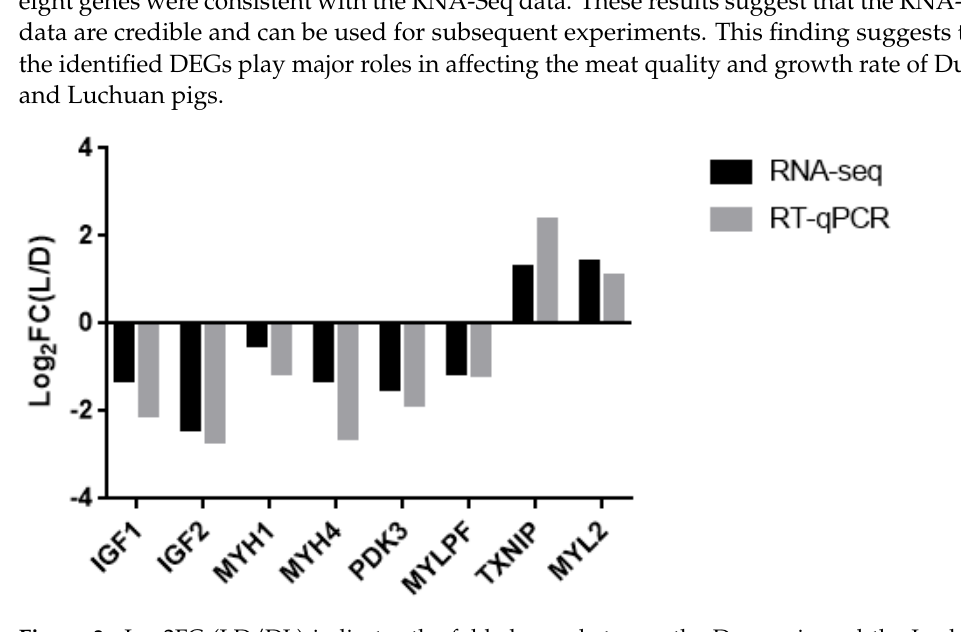
Figure 3. Log2FC (LD/DL) indicates the fold change between the Duroc pig and the Luchuan pig. The mRNA expression of different genes in the transcriptome is shown by the value of log2 ratio (LD/DL) to conveniently compare with the results of RT-qPCR. The Duroc pig represents the control group.